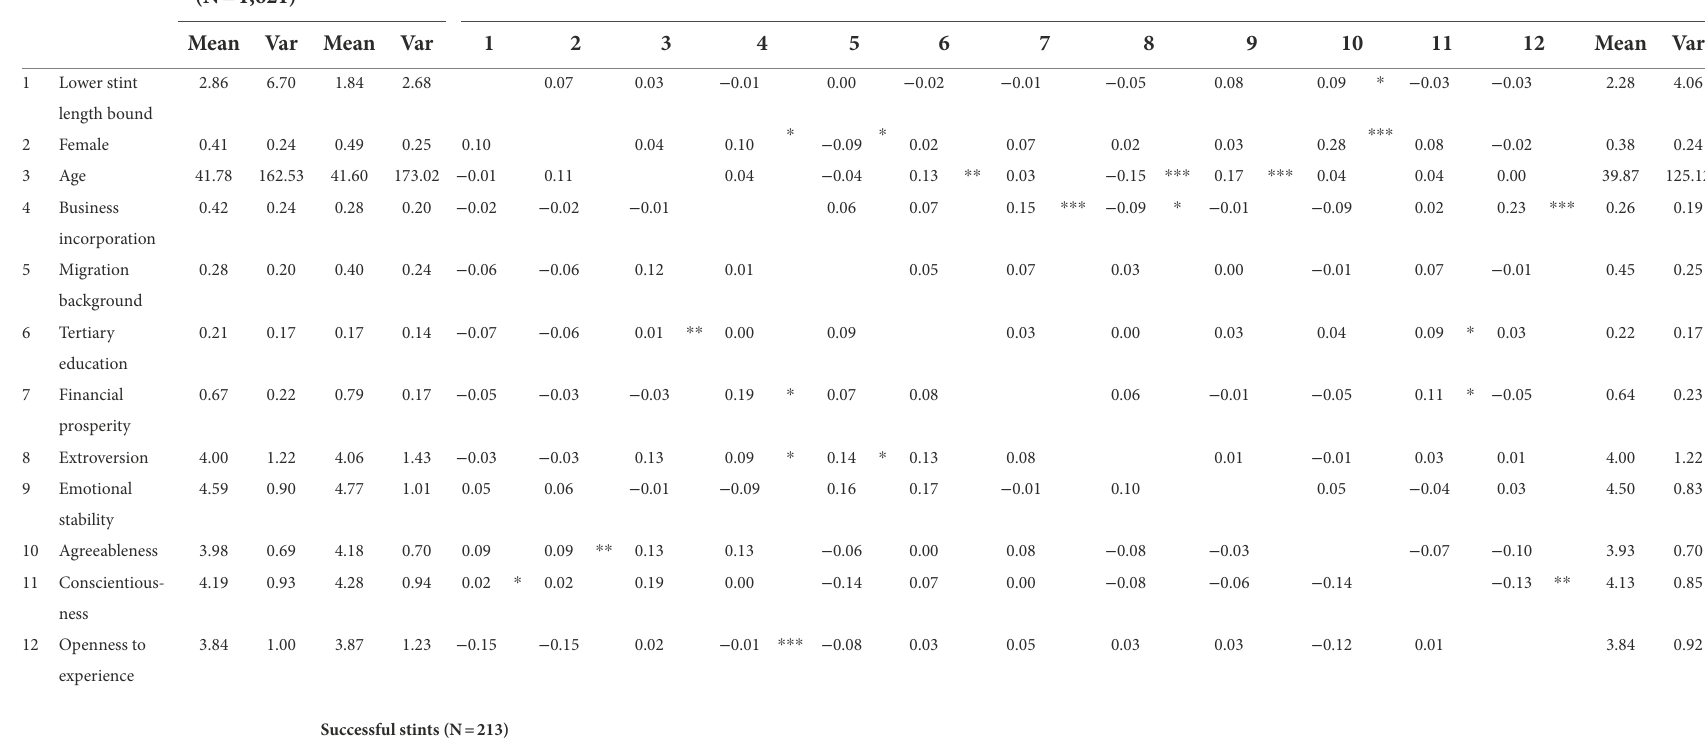
TABLE 1 Descriptive statistics and correlation